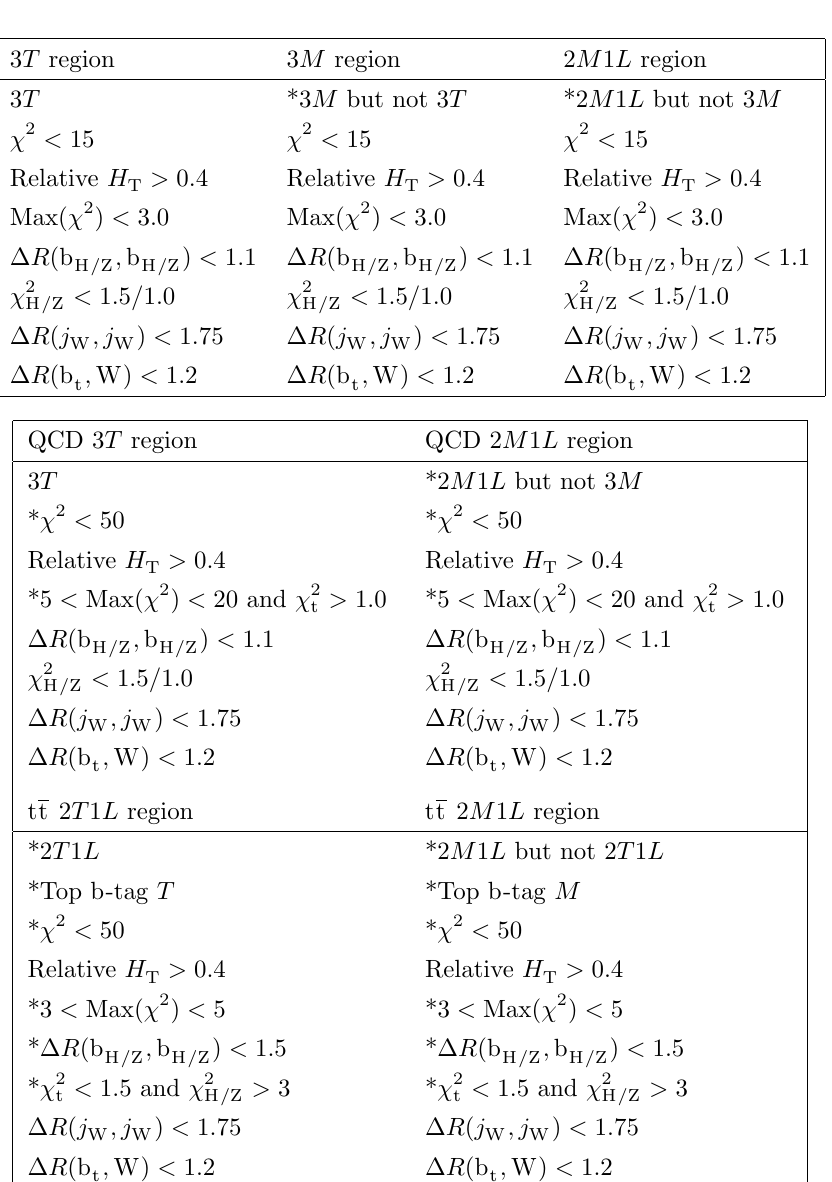
Table 2 . Criteria de(cid:12)ning the various signal and control regions. The (cid:12)rst line of each section gives the b tagging requirements. The criteria that di(cid:11)er are preceded by an asterisk \*". The bb mass requirements are di(cid:11)erent for the H ( m